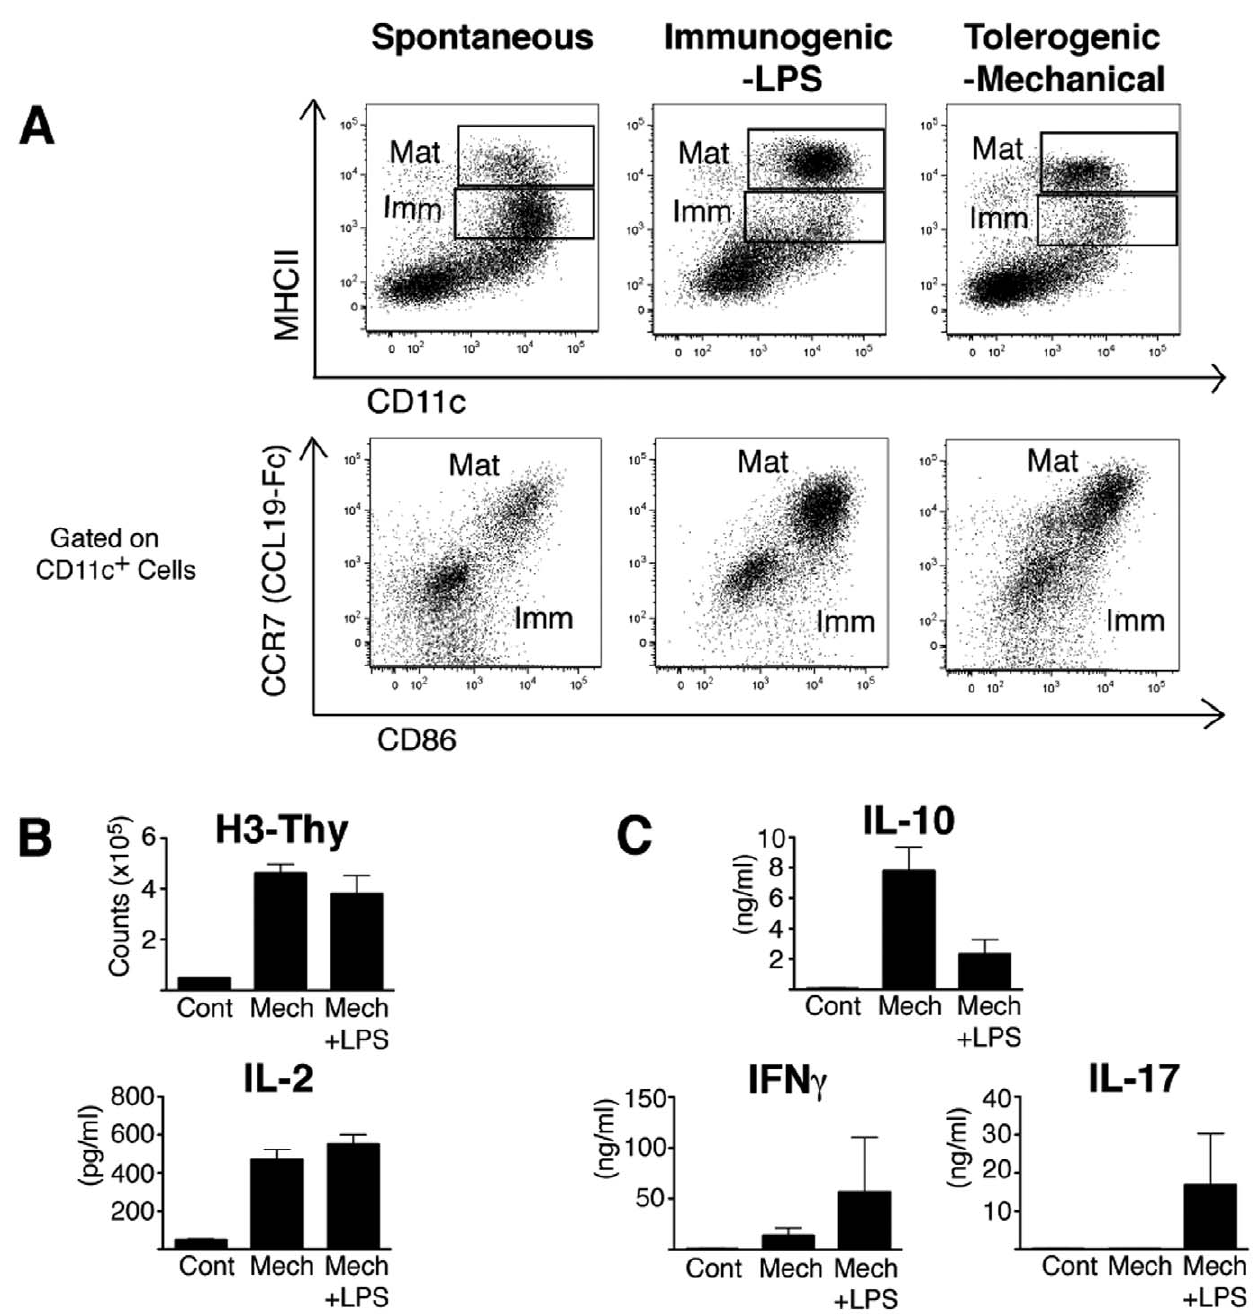
Figure 1. BMDCs Recapitulate Tolerogenic vs Immunogenic DC Function. (A) BMDCs were cultured for 5 days and either left unstimulated (spontaneous maturation, upper left panel ), treated with LPS ( upper middle panel ), or stimulated by mechanical agitation ( upper right panel ). Twenty four hours after stimulation, BMDCs were collected and analyzed by flow cytometry for maturation status. Mature (Mat) BMDCs were identified as CD11c + MHCII hi CD86 hi CCR7 hi . Immature (Imm) are CD11c + MHCII int CD86 - CCR7 - . (B,C) Day 5 BMDCs were purified/mechanically-stimulated with CD11c magnetic beads and replated with 100 ng/ml LPS (Mech + LPS) or without (Mech). Stimulated cells were pulsed for 2 hours with chicken ovalbumin peptide OVA 323–339 (10 m g/ml) and washed before injection i.v. into recipient mice. Recipient mice received treated DC injections on days 0,2, and 4. On day 7, splenocytes from recipient mice and control mice that had received noinjections (Cont) were harvested and rechallenged ex vivo with OVA peptide for 72 hours. (B) Proliferation was measured either by adding H 3 Thy during the final 18 hours of challenge or by ELISA for IL-2 levels in the culture supernatant. (C) Cytokine levels in culture supernatant associated with tolerance (IL-10) and immunity (IFN c and IL-17) were determined by ELISA. *p , 0.05. FACSplots inpartA aresingleexperimentsrepresentativeofmore than3repeats.Graphsin B,C showdatafrom3 experiments as mean + / 2